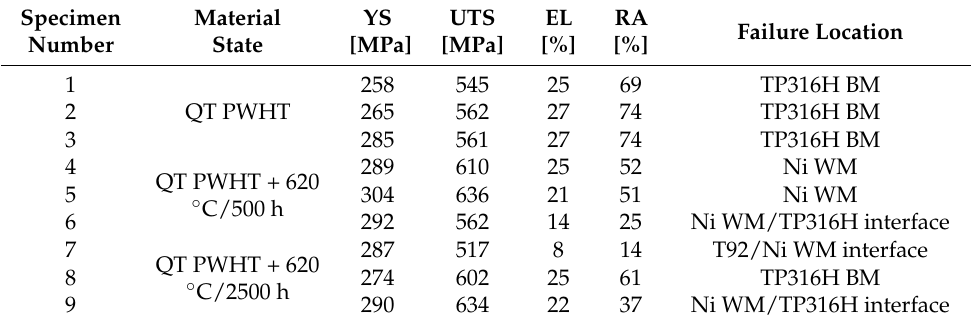
Table 2. The complete overview of room-temperature tensile properties and failure locations of